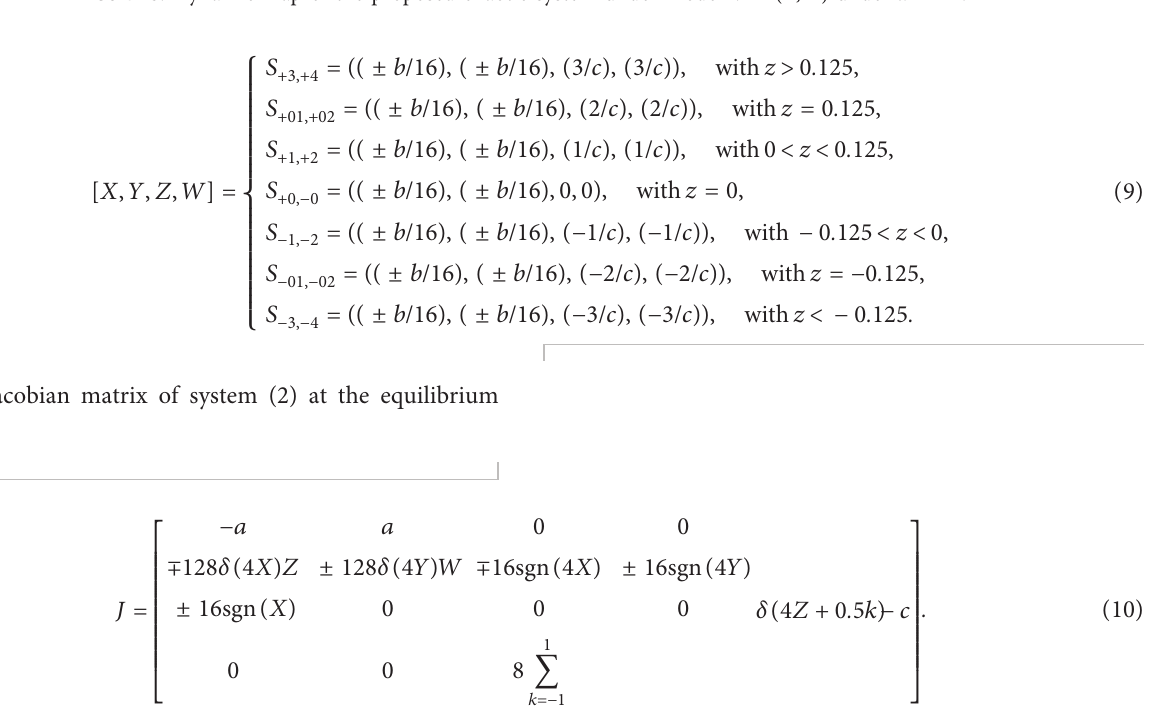
Figure 8: Dynamic map of the proposed chaotic system under mode 1: M ( − , +) under a �